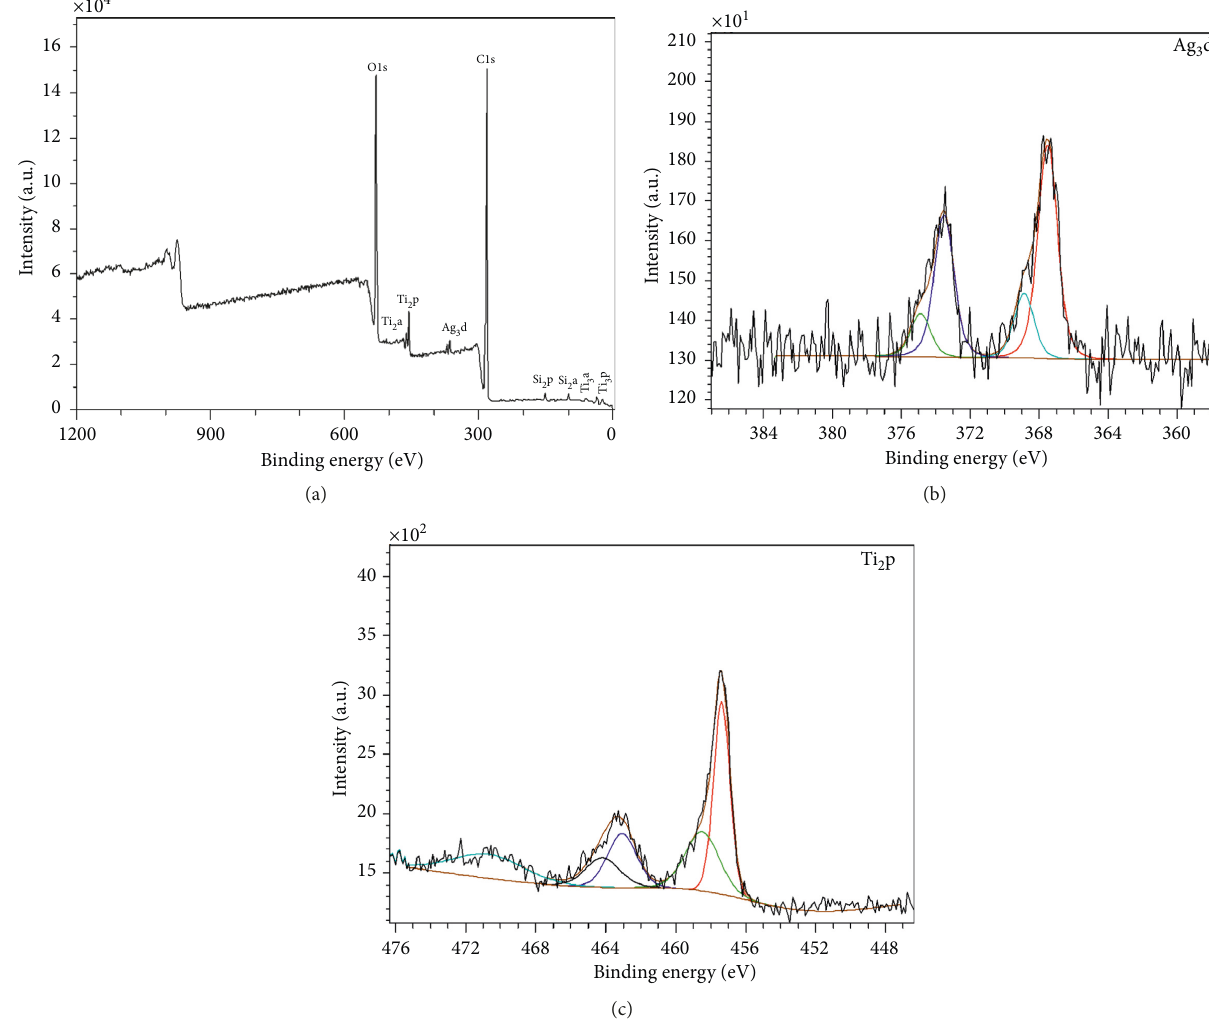
Figure 7: XPS spectra of (a) Al-MCM-41@0 1Ag/TiO